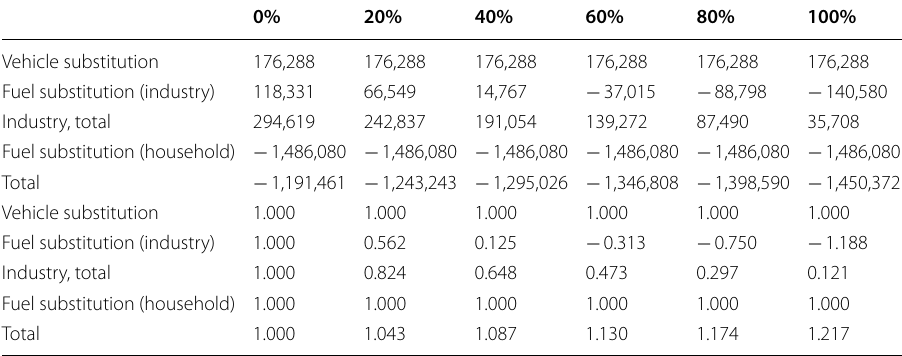
emissions by direct 2 ). Source : Authors’ 2